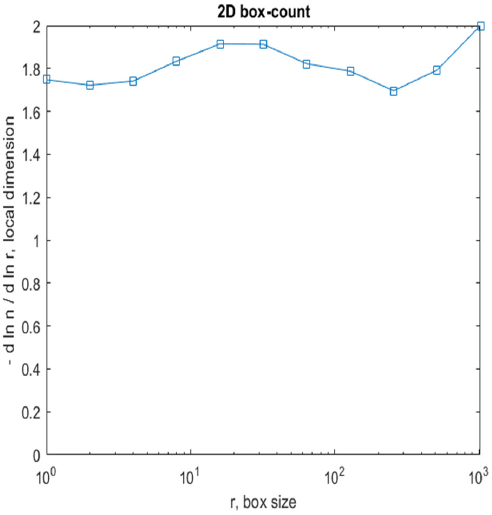
Figure 16. Two ‐ dimensional box ‐ count algorithm: fractal dimension. Figure 16. Two-dimensional box-count algorithm: fractal dimension.